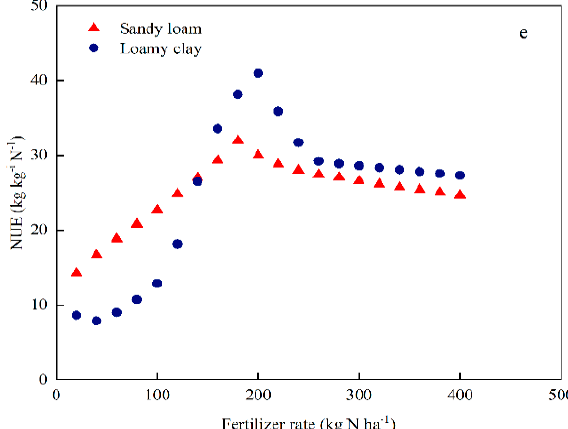
Figure 6. Responses of simulated maize yield ( a ), WUE ( b ), nitrate leaching ( c ), ammonia volatiliza- tion ( d ), and NUE ( e ) to different N fertilizer rates for sandy loam and loamy clay soils in 2014. According to the simulation results in 2014, the integrated index of 20 fertilizer N management scenarios for each textural soil was calculated (Table 4). The integrated index of sandy loam and loamy clay soils was the lowest when the fertilization rate was 40 kg ha − 1 . Under this scenario, the WUEs of sandy loam and loamy clay soils were 0.3 kg and 0.1 kg m − 3 , respectively. Their total N loss was 6.2 and 0.46 kg ha − 1 , and their crop yields only reached 17.4 and 5.0% of the maximum. Their NUEs were 16.7 and 7.9 kg kg − 1 , respectively. When the N fertilizer rate was 180 kg ha − 1 for sandy loam soil, and it was 200 kg ha − 1 for loamy clay soil, their WUEs were 1.8 and 2.7 kg m − 3 , respectively, and their NUEs reached 32.0 and 40.9 kg kg − 1 , respectively. The crop yields reached the maximum, and the integrated index also reached the highest, which could be recommended as BMPs of the two textural soils for maize yield in this region. Table 4. Integrated index simulated by WHCNS model under different N rates for two soil textural soils in 2014.